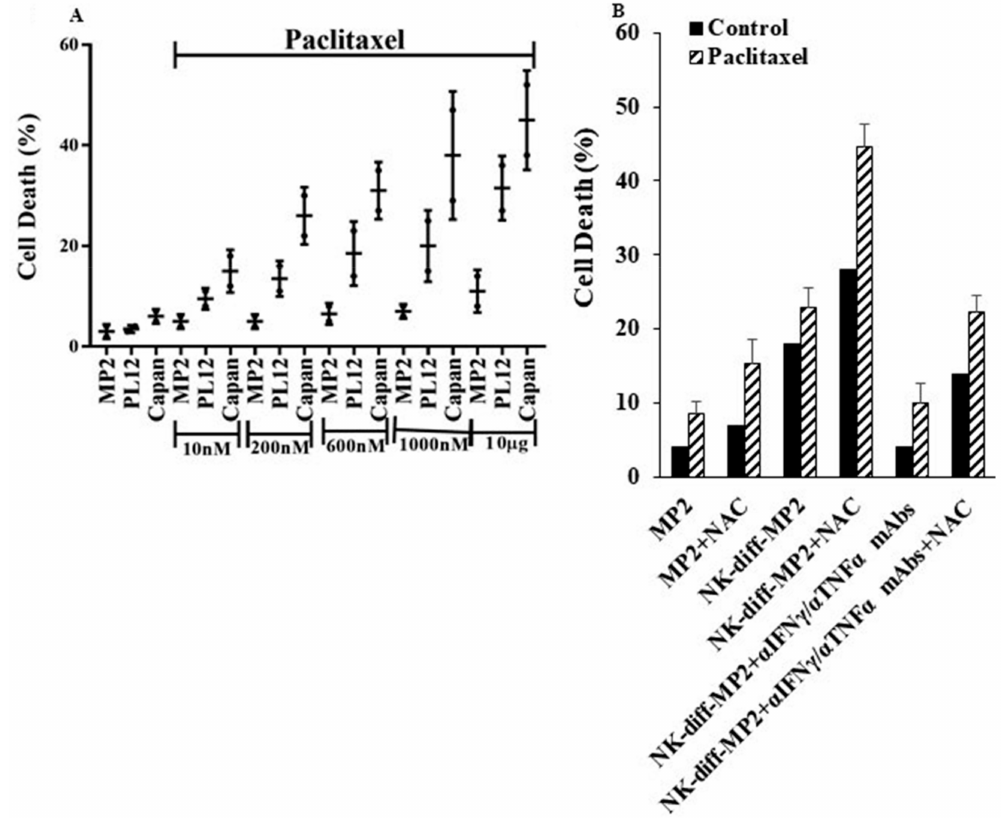
Figure 6. Paclitaxel induced significant cell death in patient-derived di ff erentiated PL12 and Capan and NK-di ff erentiated MP2 tumors treated with and without NAC. MP2, PL12, and Capan tumors (1 × 10 5 tumors) were treated with or without Paclitaxel for 18–20 h before the viability of cells was determined using propidium iodide staining. p -values of < 0.05 were obtained for di ff erences between MP2 vs. PL12 and Capan at the concentrations of 10, 200, 600, and 1000 nM and 10 g of Paclitaxel ( n = 2 / each experimental condition) ( A ). MP2 tumors were di ff erentiated with NK supernatants in the presence and absence of anti-IFN- γ and anti-TNF- α as described in Materials and Methods section for a period of 5 days before they were washed and treated with / without NAC (20 nM) for 24 h, followed by paclitaxel treatment from 10 nM to 600 nM for 18–24 h. The viability of cells was determined by staining with propidium iodide ( n = 3 / each experimental condition) ( B